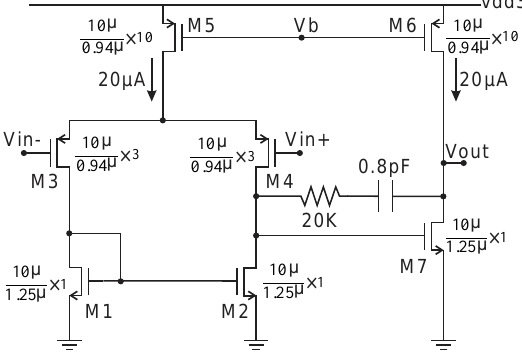
Figure 6. Schematic of op-amp1 used in the 2.5 V HV LDO.